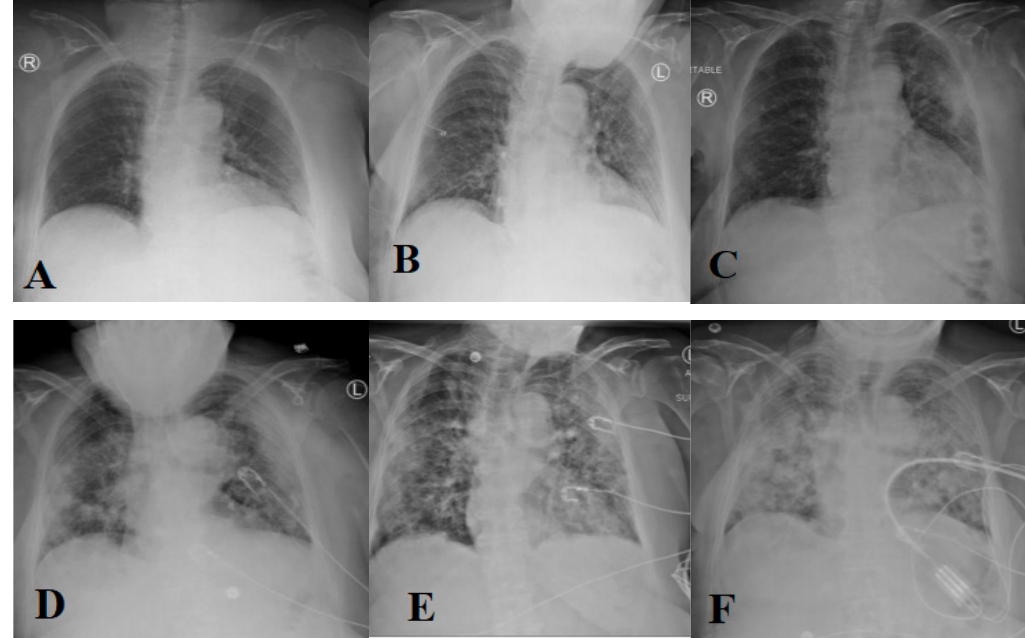
Figure 5. ( A – F ) subfigures show progression of an X-ray image for a COVID-19 patient across days (1, 3, 6, 7, 8, and 10, respectively).